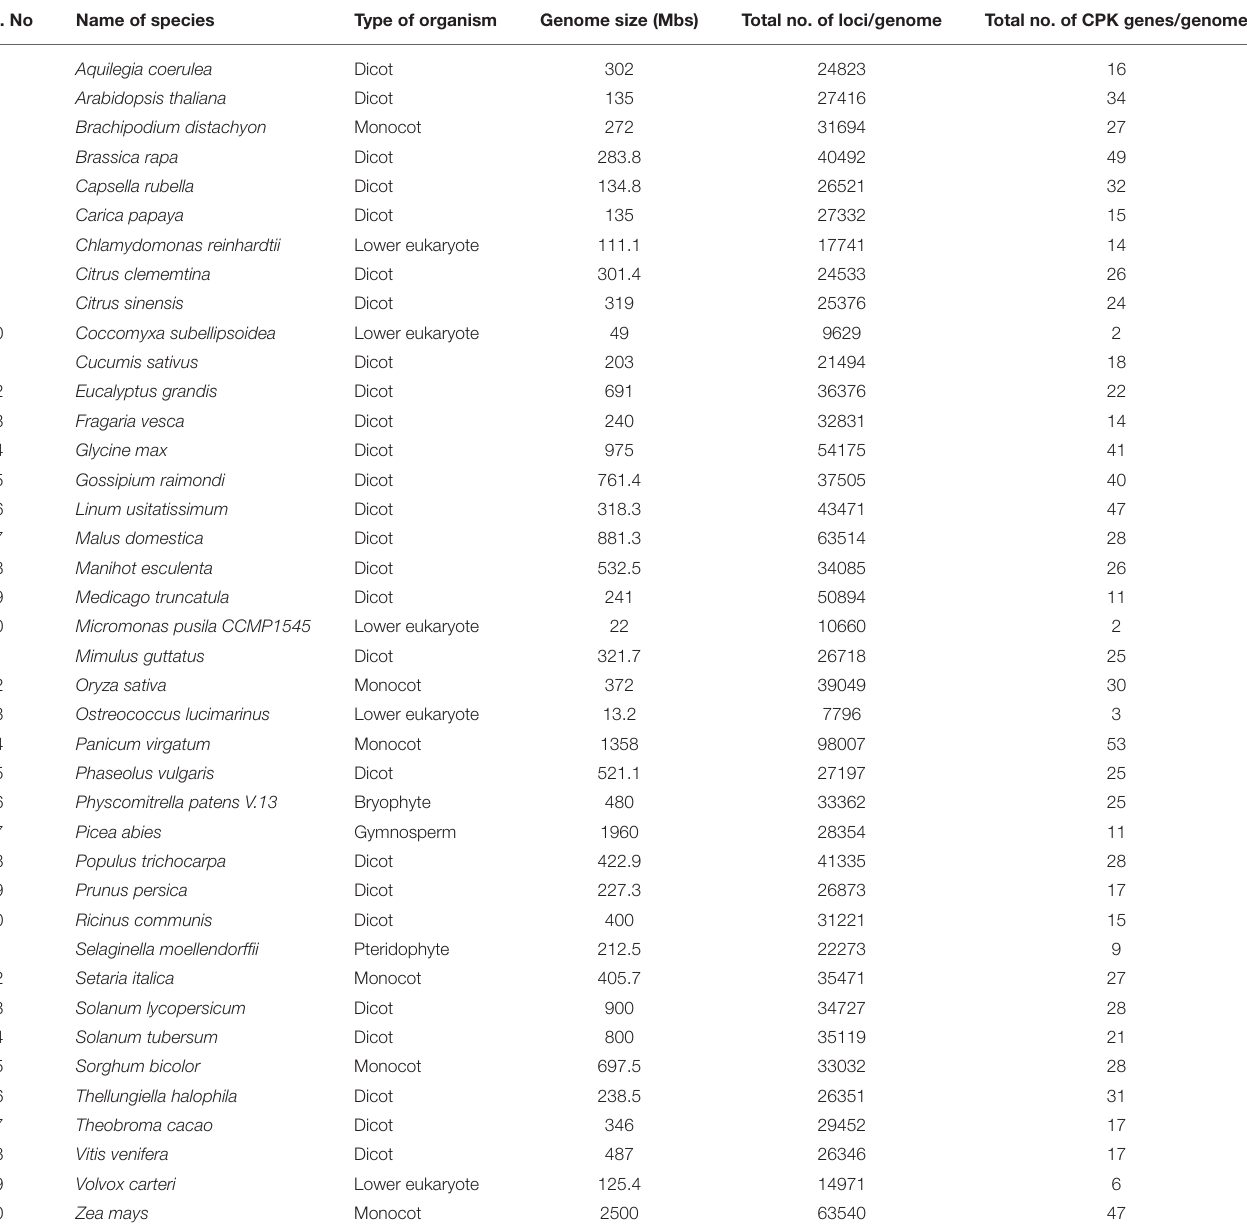
TABLE 1 | Genome size of different plant species used in this study and number of CPK genes present in their respective genomes. Sl.